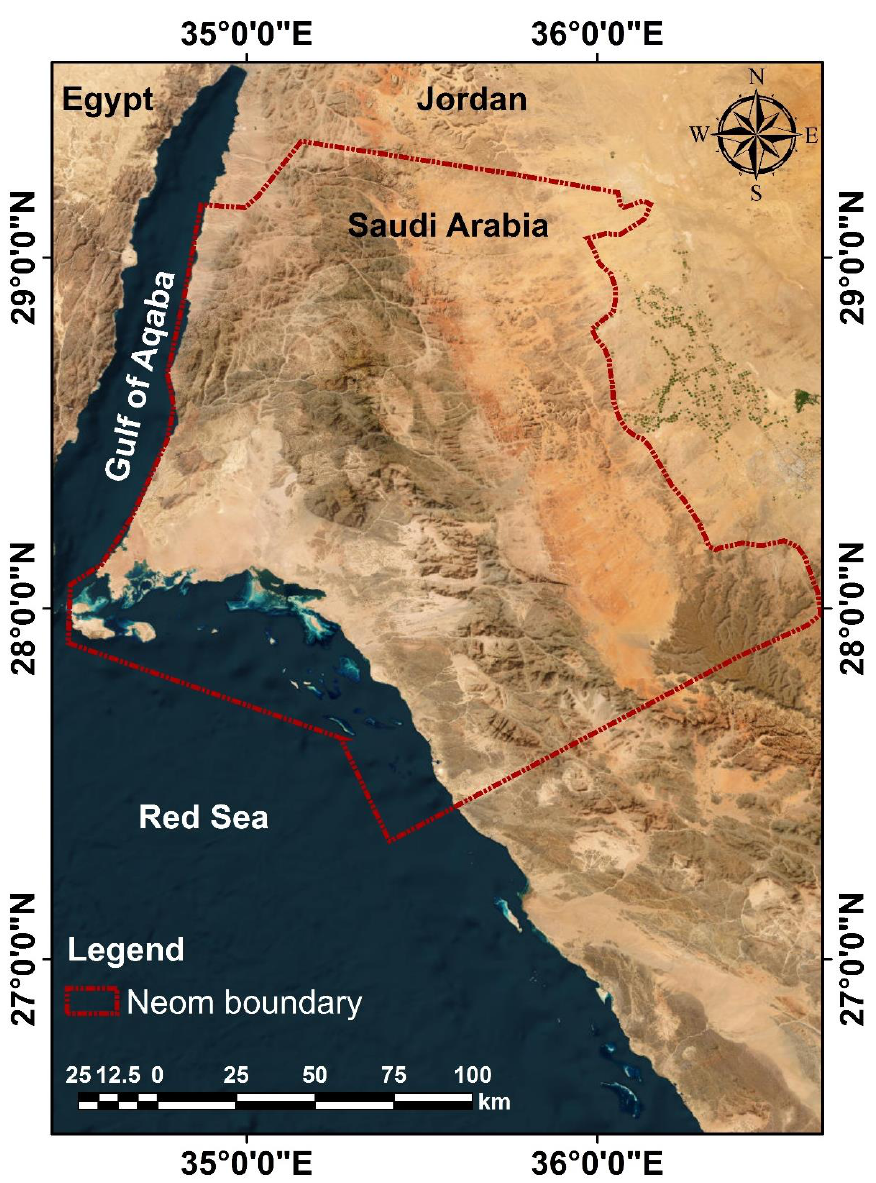
Figure 1. Map displaying the borders of Neom, which covers 22,617 km 2 along the east coast of the Red Sea and the Gulf of